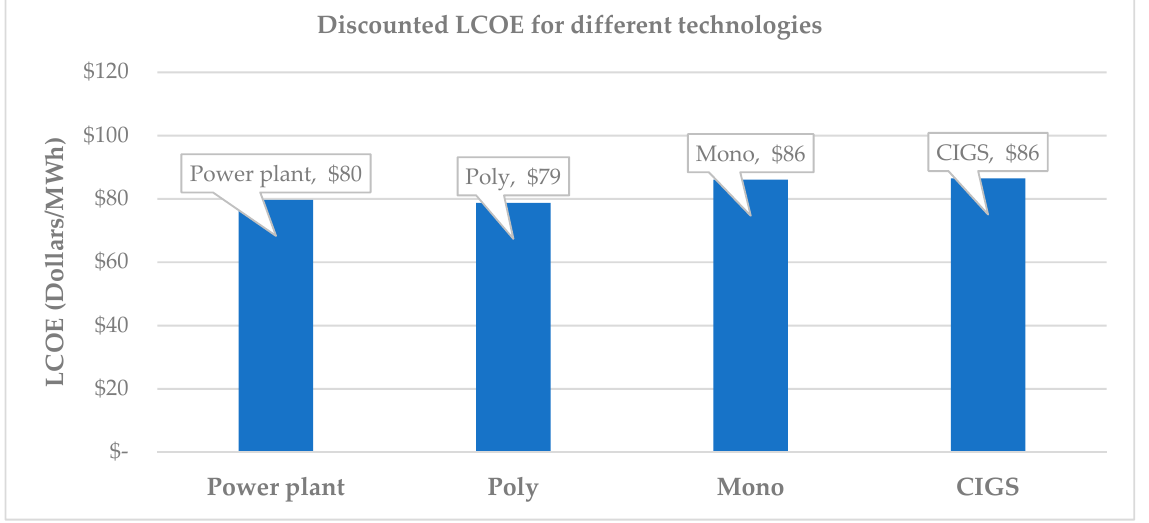
14 of 21 Figure 12. System cost for the power plant. Discounted levelized cost of energy (LCOE) is calculated using Equation (8) at an interest rate of 3%, which is the Department of Energy (DOE) discount rate for projects related to energy conservation and renewable energy for 2018 [40]. The lifecycle of the powerplant is considered to be 25 years, which is the standard lifetime of any solar PV plant [37]. Energy generated was extrapolated for the life of the project from the first two years of energy production. The degradation rate for crystalline silicon modules and CIGS was assumed to be 0.5% [41,42].